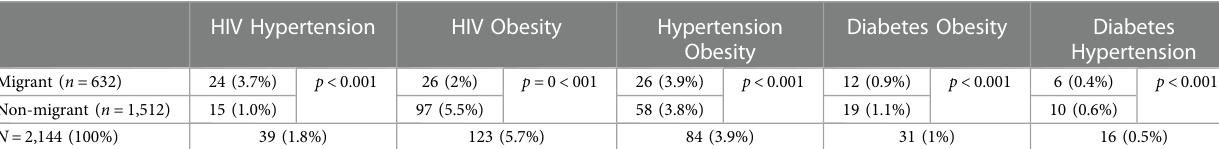
TABLE 3 Dual-disease combinations by migration status .